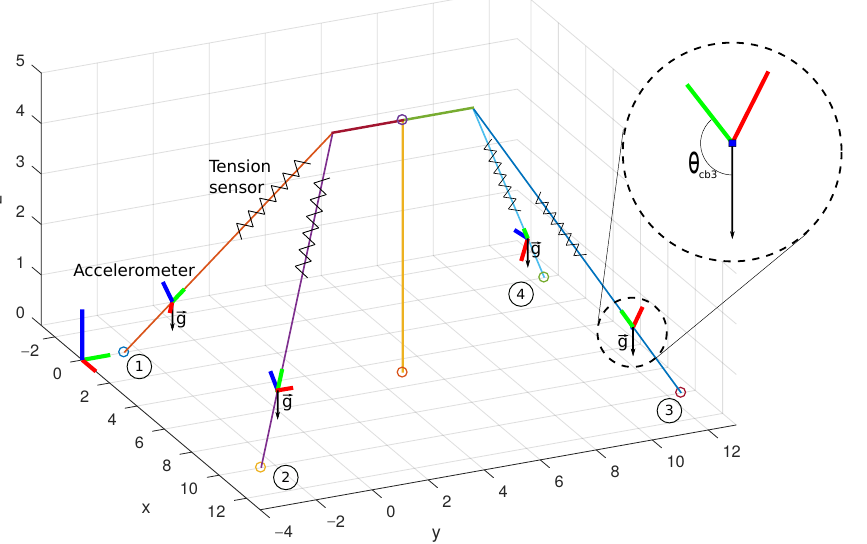
Figure 14. Analytical representation of the mockup tower. The accelerometer data must receive careful analysis when dealing with global and local axes reference. The supplied data of the accelerometer device are considered a local axis reference. Thus, the local axis reference must be converted to a global axis. Notice in Figure 15 that the y-axis local reference of the devices is always parallel to the cables and rotated concerning the global axis represented in the left corner of the plot. If the accelerometer data are imported in the global reference, the local axes coincide with the global axes, and the g vector points to an arbitrary direction as is shown in to calculate a rotation matrix and apply an operation to achieve the correct reference.